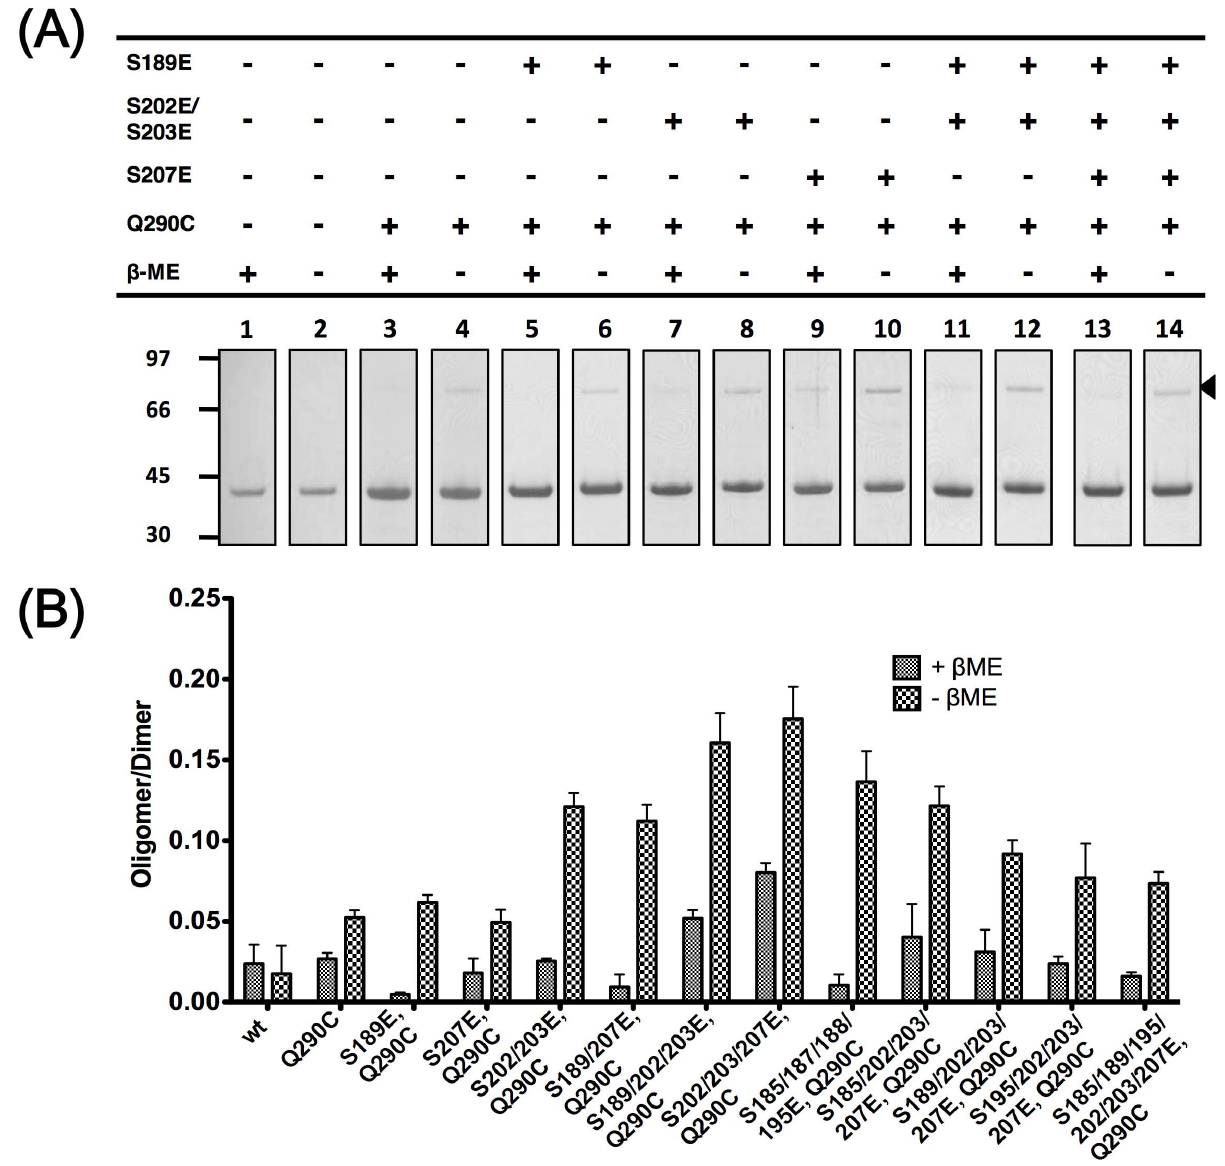
Figure 5. Effect of phosphomimicking negative charges on di-domain self-association. (A) Representative SDS-PAGE strips from disulfide trapping experiments of di-domain mutated at sites known to be phosphorylated by GSK3 and SRPK1. The arrow denotes the position of disulfide- linked di-domain on the gel. Strips from other mutants are included in the supplemental material. (B) Quantification of the self-association potential of all phosphomimicking mutants from this study. Bars represent average results from three independent